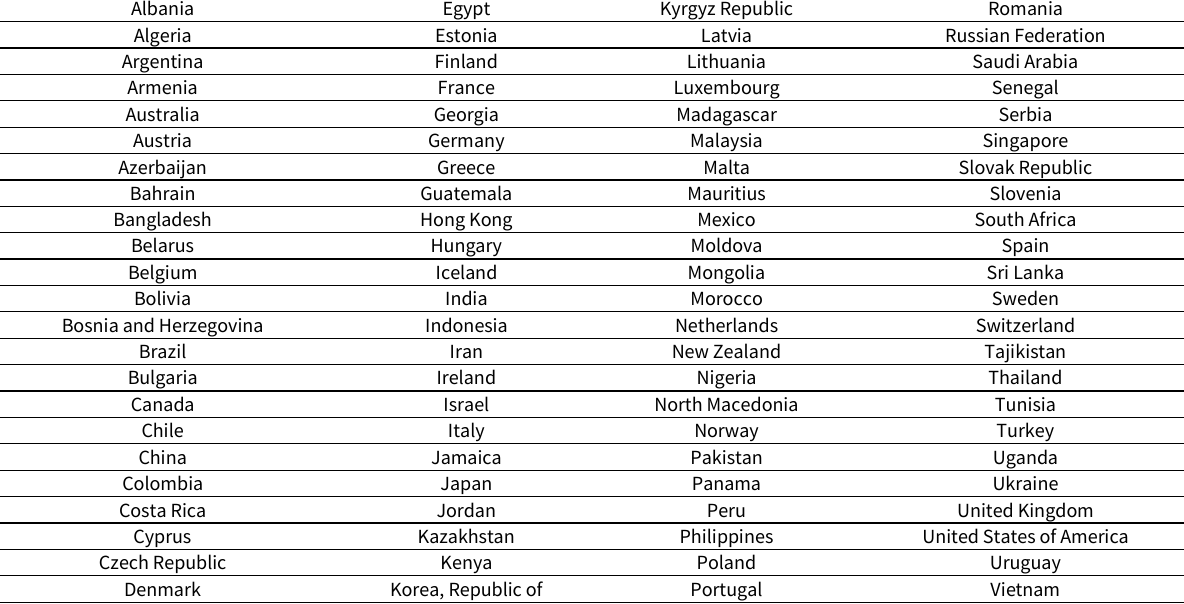
Table A2. Countries in the